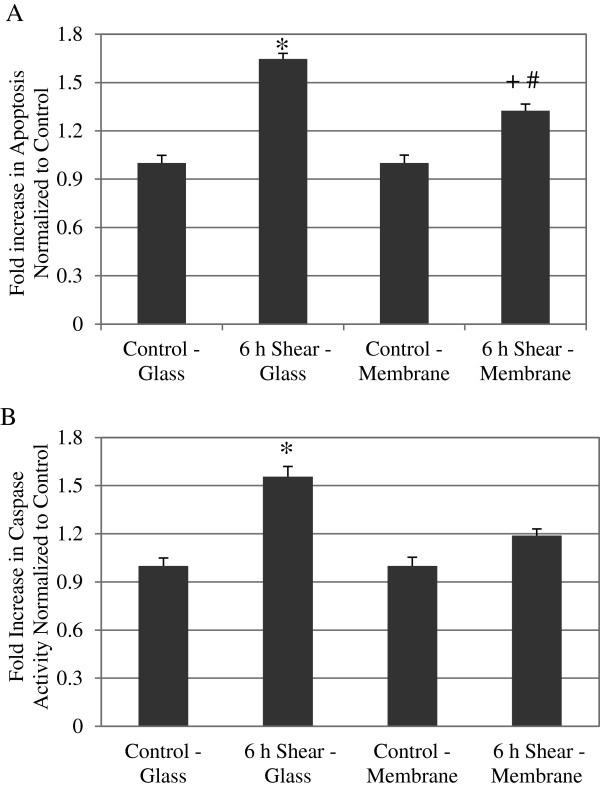
Shear stress on cells plated on membrane induced apoptosis similar to cells on glass. (A) TUNEL positive cells are presented as fold increase over static control on either substrate. Sheared cells demonstrated significant higher apoptosis compared to static control cells on both glass and membrane substrate. However, sheared cells on membrane cells exhibited significantly less apoptosis when compared to the sheared cell on glass. Data represent average ± standard error for n ≥ 4. * P < 0.01 compared to control-glass cells, + P < 0.01 compared to control-membrane cells, and # P < 0.01 compared to 6hr shear-glass. (B) Caspase-3 and −7 results are presented as fold increase over static control BAEC, and shear stress also induced significantly increased caspase 3/7 activities compared to static control cells on both substrates. Again, sheared cells on membrane exhibits significantly decreased caspase activity compared to sheared cells on glass. Data represent average ± standard error for n ≥ 5. * P < 0.01 compared to control-glass cells, + P < 0.05 compared to control-membrane cells, and # P < 0.05 compared to 6 hr shear-glass.